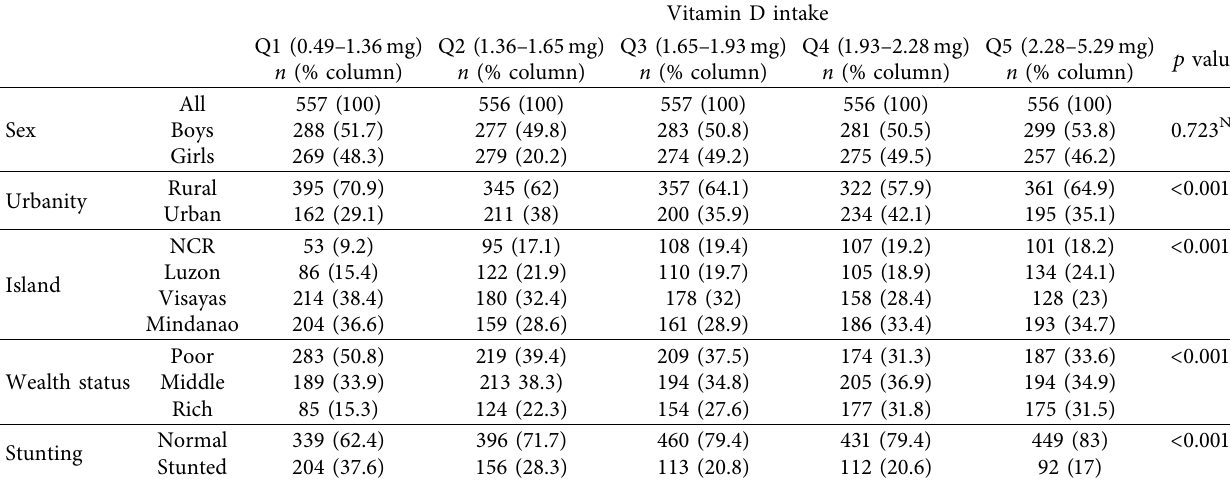
Table 3: Usual vitamin D intake level by sex, urbanity, island group, wealth status, and stunting.